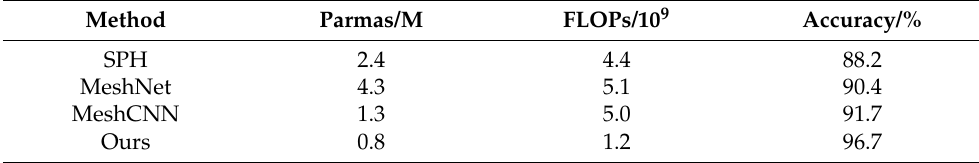
Table 2. Comparison of the classification accuracy of different pooling sampling